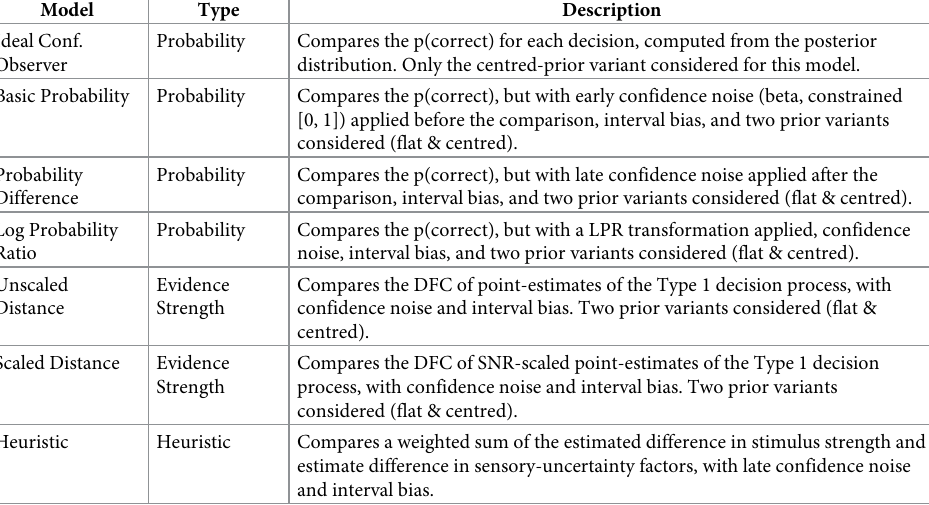
Table 2. Summary of the seven base models. Models spanned all three metric types and considered different imple- mentations of confidence noise, prior distributions, and confidence-variable transformations. Standard unbiased Gaussian confidence noise is used unless noted otherwise. There are twelve distinct models for comparison when including the prior variants. Model